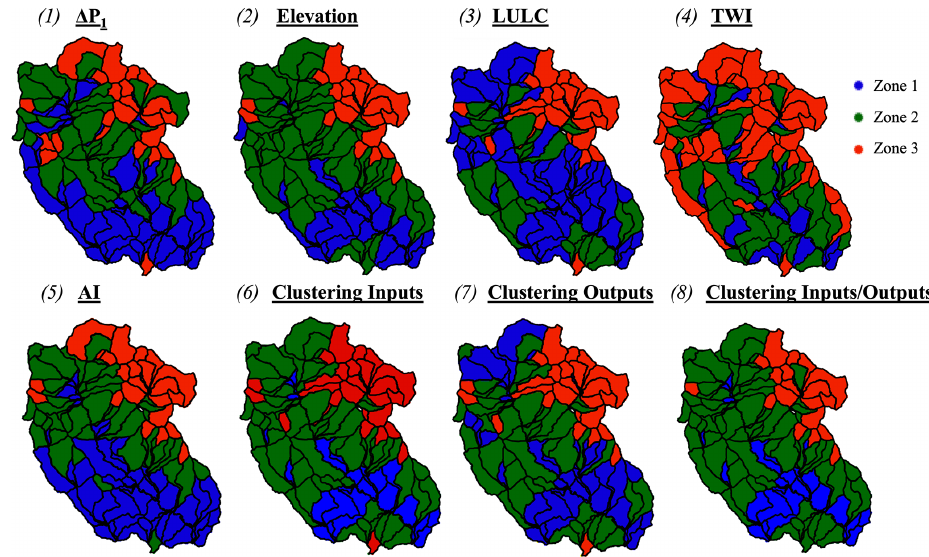
Figure 5. Spatial distribution of hillslope zones derived from the eight selected clustering approaches: (1) (cid:49)P 1 , (2) elevation, (3) land cover (LULC), (4) topographic wetness index (TWI), (5) aridity index (AI), and clustering with (6) inputs, (7) outputs, and (8) input and output